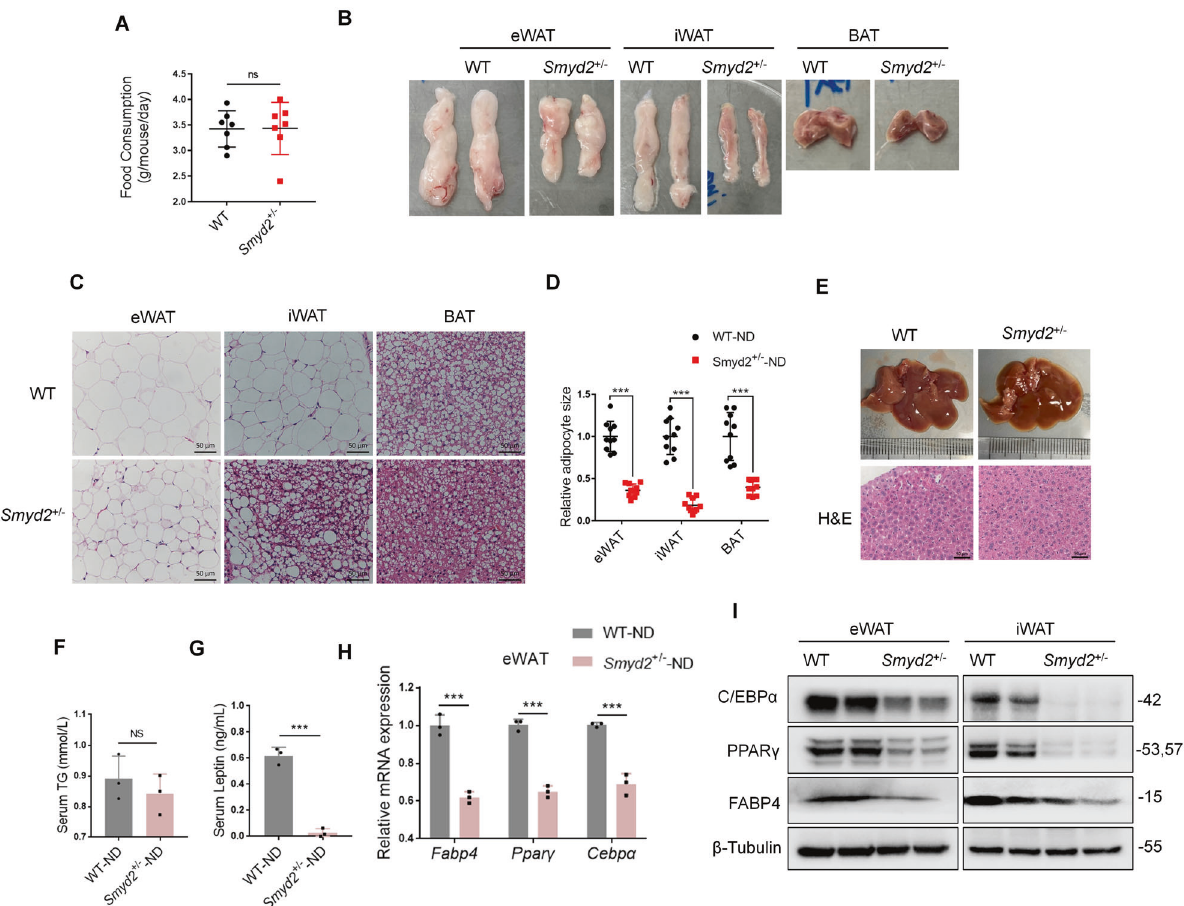
Fig. 6 Smyd2 + / − mice exert signi fi cant fat loss. The Smyd2 heterozygous knockout ( Smyd2 + / − ) mice and the littermate controls (WT) were obtained as we described previously [20]. A The food intake of Smyd2 + / − mice and their littermate controls under the normal diet. B The representative images of gross morphology of eWAT, iWAT and BAT from both WT and Smyd2 + / − mice. n = 3 mice/group. C, D The paraf fi n- embedded sections of eWAT, iWAT, and BAT from both WT and Smyd2 + / − mice were subjected to H&E staining and then the adipocyte areas were measured. Scale bar, 50 μ m. E The representative gross morphology images and H&E staining images of liver from both WT and Smyd2 + / − mice. Scale bar, 50 μ m. F, G The serum TG and leptin levels of WT and Smyd2 + / − mice, n = 3. H The mRNA levels of adipogenesis marker genes ( Ppar γ , Cebp α , and Fabp4 ) in eWAT from WTand Smyd2 + / − mice were detected by RT-qPCR. I The protein expressions of PPAR γ , C/EBP α , and FABP4 of eWAT and iWAT from WT and Smyd2 + / − mice were detected by western blot analysis. Data are presented as mean ±SD. *** p of adipogenesis markers (PPAR γ , C/EBP α , and FABP4). As shown in Fig. S3D, the mRNA level of the Cebp α gene was signi fi cantly upregulated, while the mRNA levels of Fabp4 genes were decreased in eWAT from HFD-fed Smyd2 + / − mice compared to WT mice. But in iWAT and BAT, there were slight changes in the expression of adipogenesis marker genes ( Ppar γ , Cebp α , and Fabp4 ) between WT and Smyd2 + / − mice. Strangely, the protein levels of adipogenesis markers (PPAR γ , C/EBP α , and FABP4) showed a slight upregulation trend in eWAT and iWAT from Smyd2 + / − mice (Fig. S3E), suggesting that the expressions of adipogenesis markers in HFD-induced Smyd2 + / − mice showed inconsistent trends. These seemingly contradictory trends may be due to the heterozygous mice ( Smyd2 + / − ) we used, which fed by HFD exhibit a complex overall metabolic state.